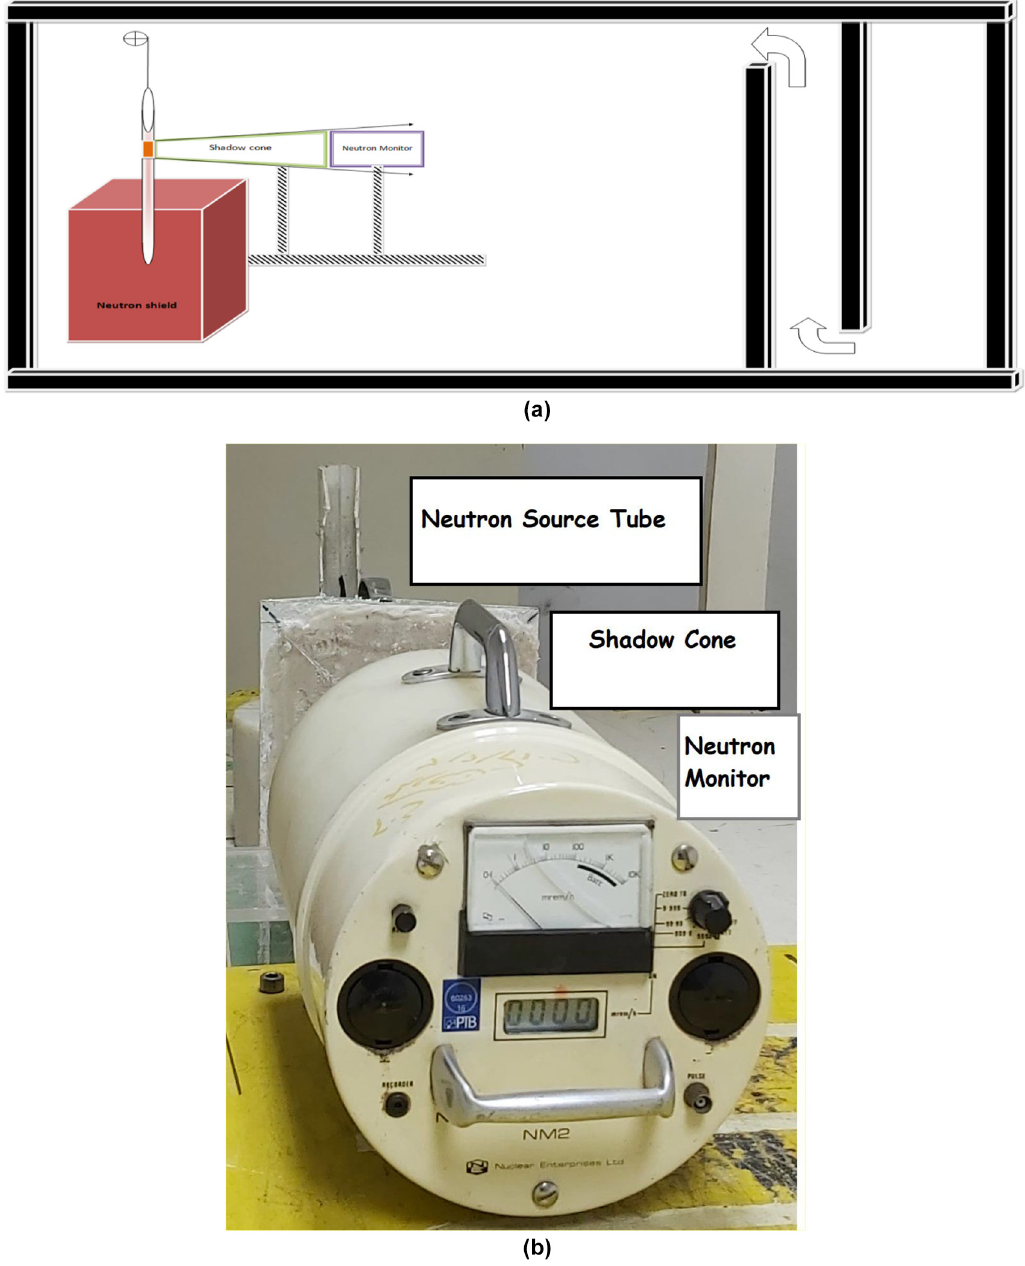
Fig. 1. Schematic diagram of the neutron irradiation facility (a) and its photograph